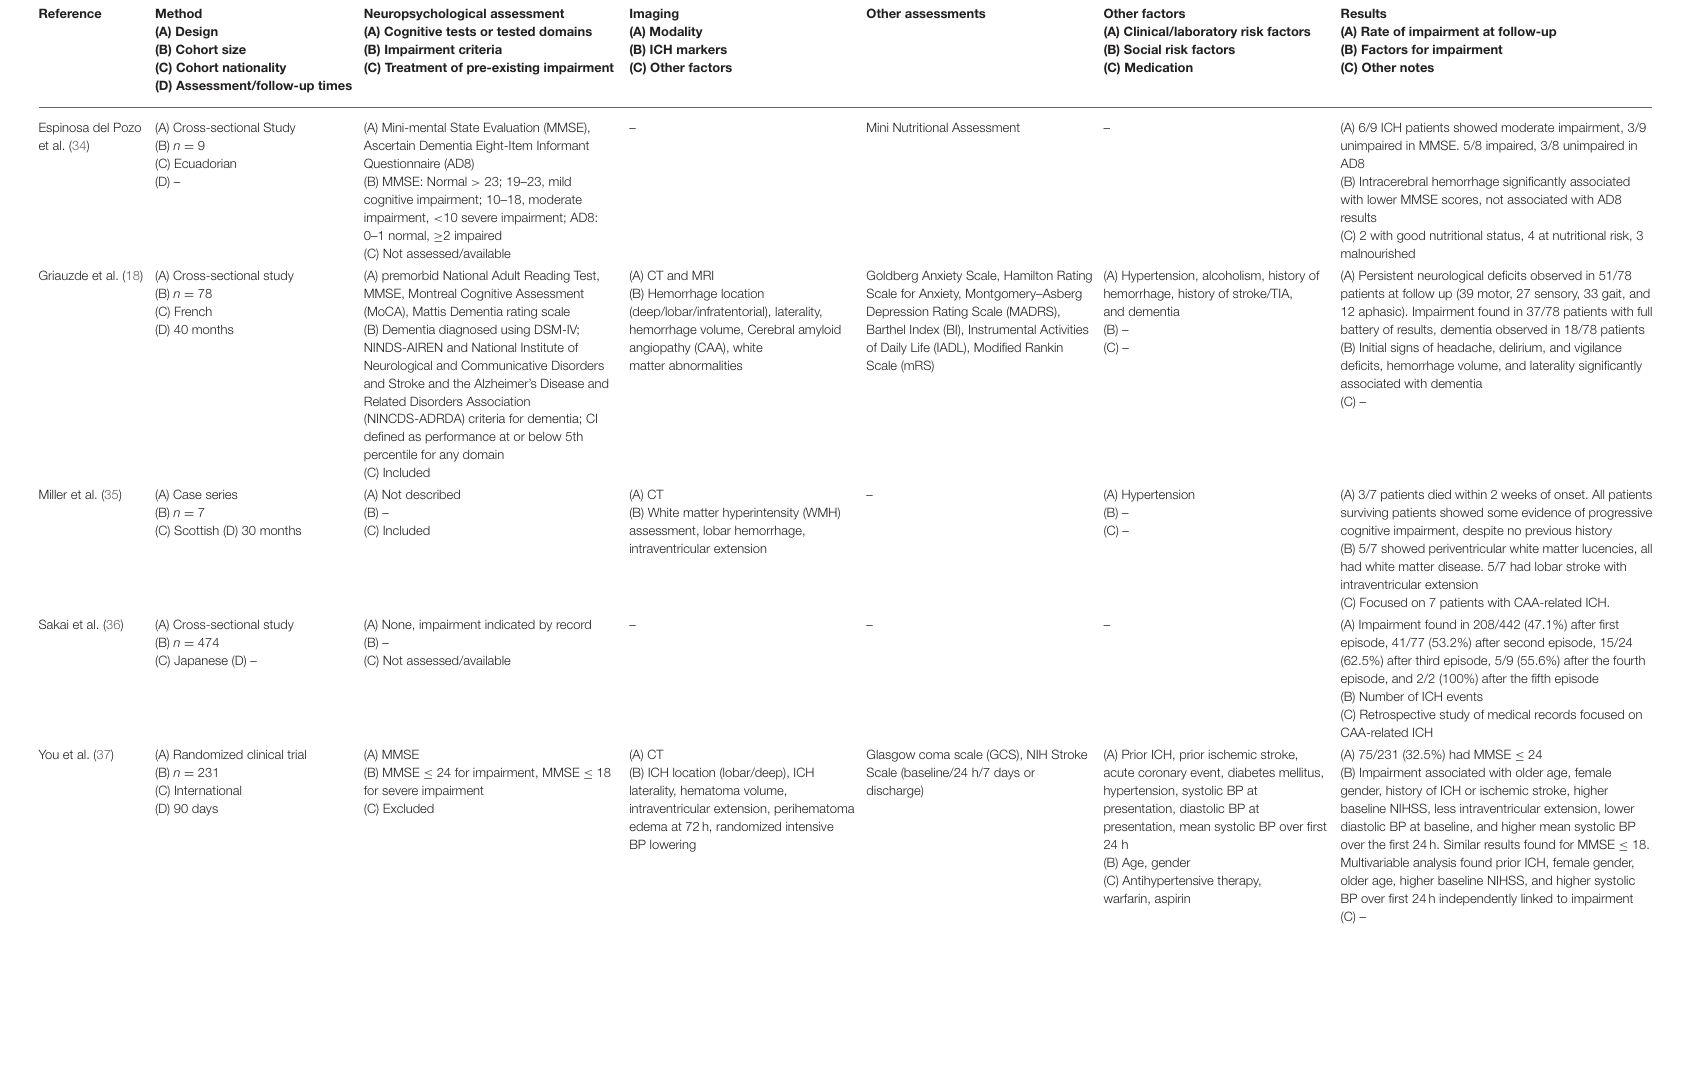
TABLE 3 | Summary of methods and findings from other study